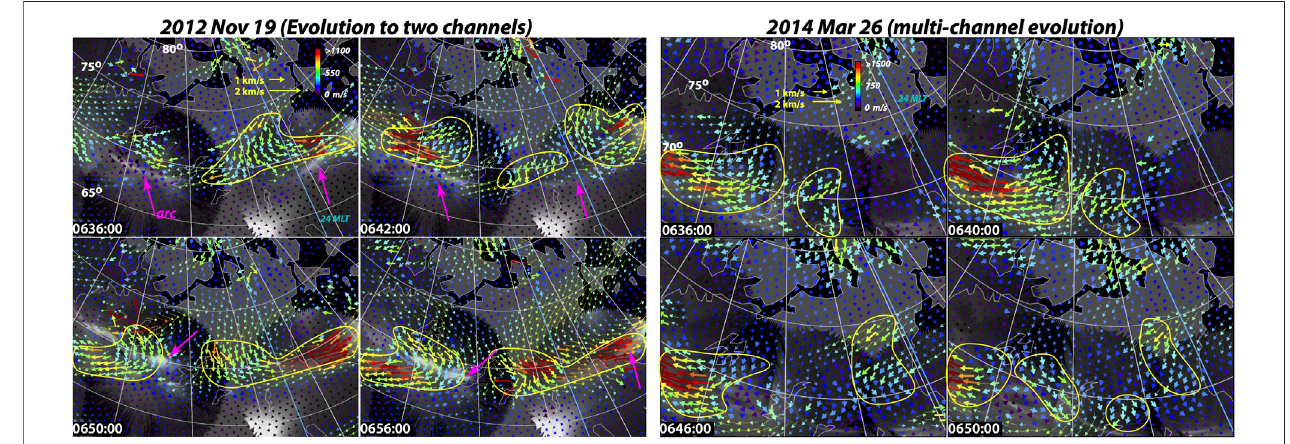
FIGURE 7 | Same as Figure 4 , except for two events ( left : November 19, 2012; right : March 26, 2014) showing fl ow evolution to two or more fl ow channels. Yellow curves approximately encircle the identi fi ed fl ow channels in each